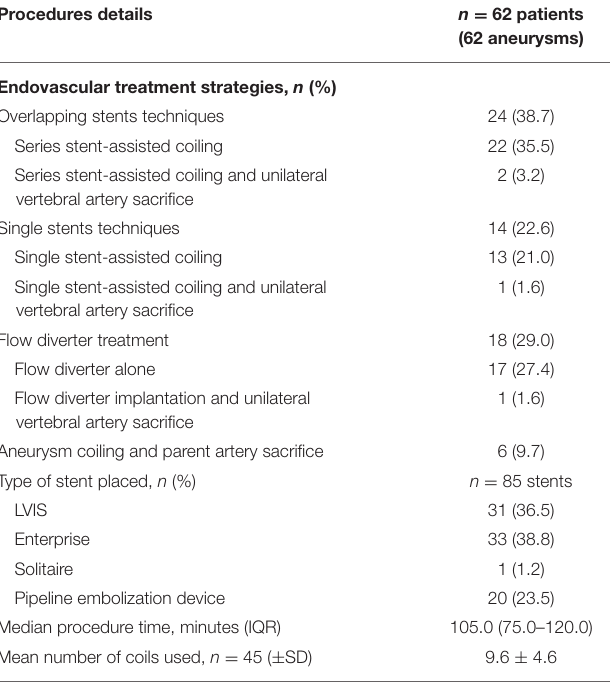
TABLE 2 | Endovascular procedure-related data.